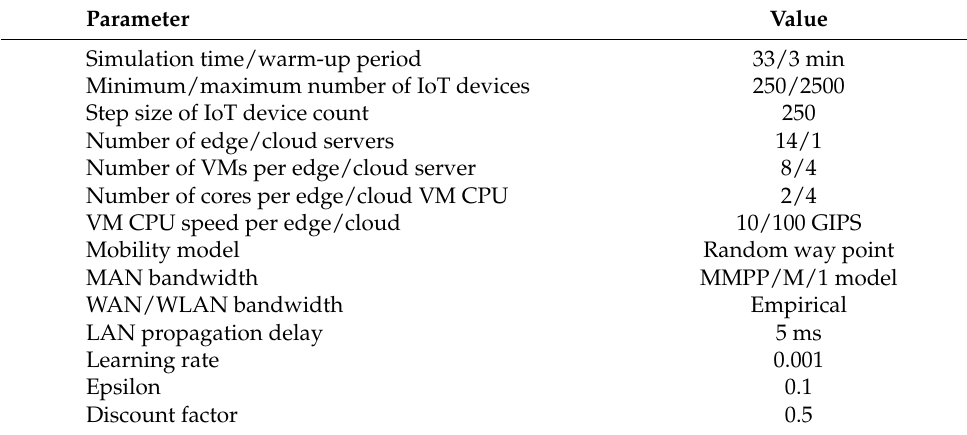
Table 5. Simulation parameters [65].